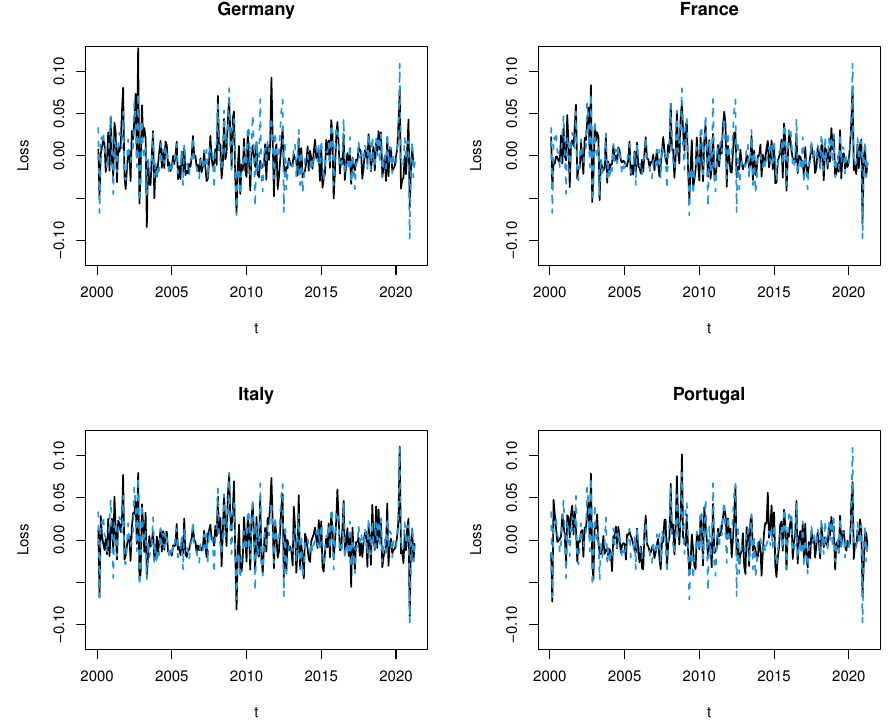
Figure 1. Losses of Spanish stock market index (dashed line in blue) and stock market indexes of four countries in the European Union (solid line in